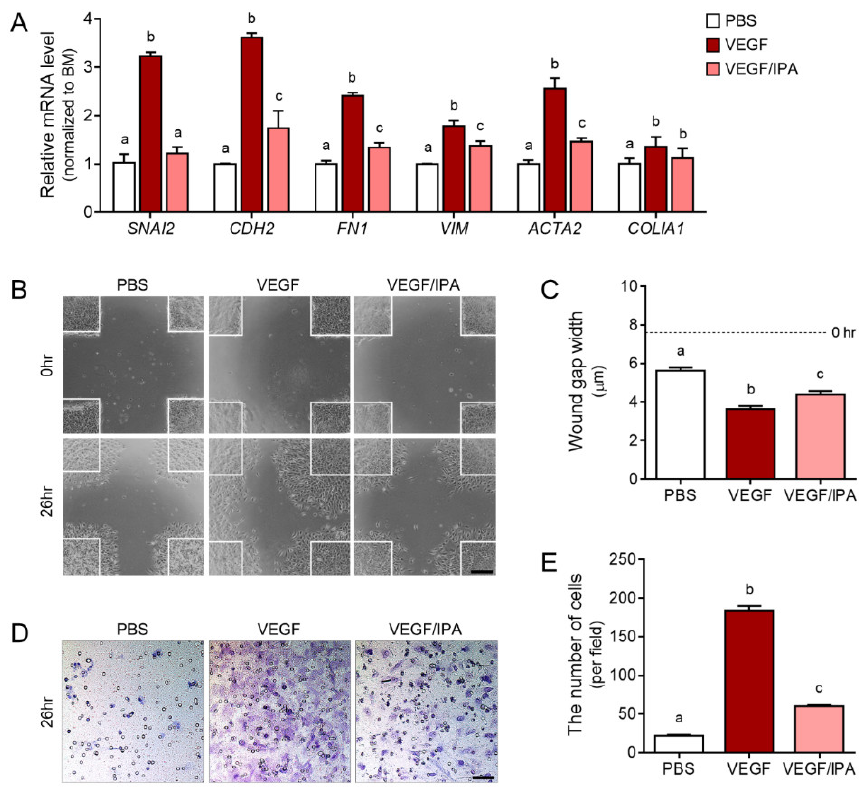
Figure 6. The inhibitory effects of the migratory mesenchymal phenotype on the EMT process in IPA-treated ARPE19 cells. ( A ) EMT-related factor mRNA levels in PBS- (white), VEGF- (red), or VEGF/IPA-treated (pink) ARPE19 cells measured by qRT-PCR analysis. ( B ) Representative bright- field images show that VEGF resulted in a significantly increased migration speed compared with PBS. This acceleration of gap closure was also prevented by IPA treatment. ( C ) Wound closure is expressed as the remaining area uncovered by the ARPE19 cells. The wound gap at time point 0 h is set in the quantified graph. ( D ) Representative images of the transwell migration assay of ARPE19 cells with PBS, VEGF, or VEGF/IPA. Hematoxylin-stained ARPE19 cells show a purple color, and ( E ) the graphical representation of the transwell migration assay of ARPE19 cells with VEGF/IPA shows a reduction in transwell migration compared to VEGF. Means denoted by different letters indicate significant differences between the groups ( p < 0.05). Scale bar = 100 µm; ACTA2, Actin Alpha 2, Smooth Muscle; CDH2, cadherin 2; COLIA1, collagen type 1 alpha 1; FN1, fibronectin 1; IPA, ishophloroglucin A; SNAI2, Snail family transcriptional repressor 2; VEGF, vascular endothelial growth factor; VIM,